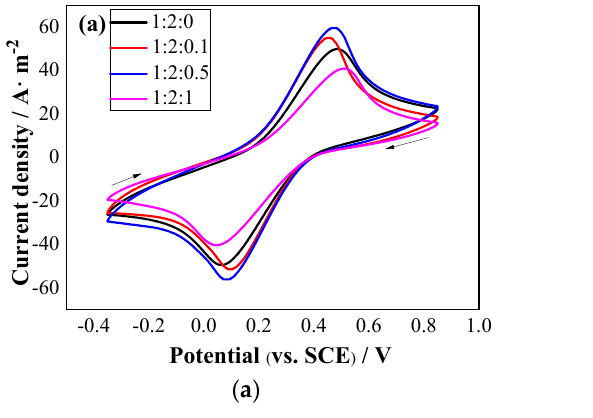
( a ) ( b ) Figure 5. ( a ) Cyclic voltammogram of the DESs with 0.1 mol·L − 1 FeCl 3 ·6H 2 O in different tempera- tures at the scan rates of 50 mV·s − 1 ; ( b ) electrochemical impedance spectroscopy of the DESs with 0.1 mol·L − 1 FeCl 3 ·6H 2 O dissolved.